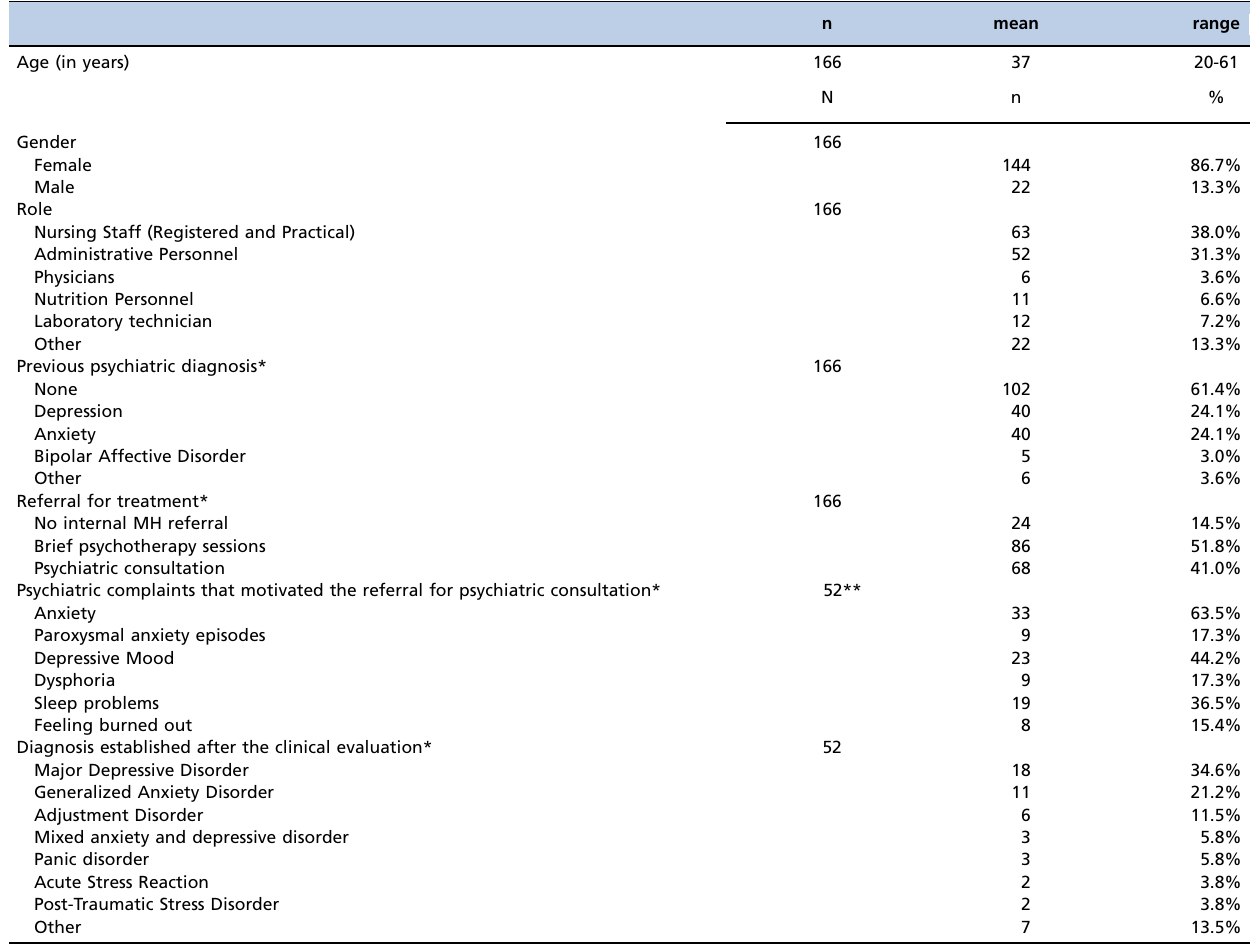
Table 2 - Characteristics of the HCWs who sought Mental Health care under